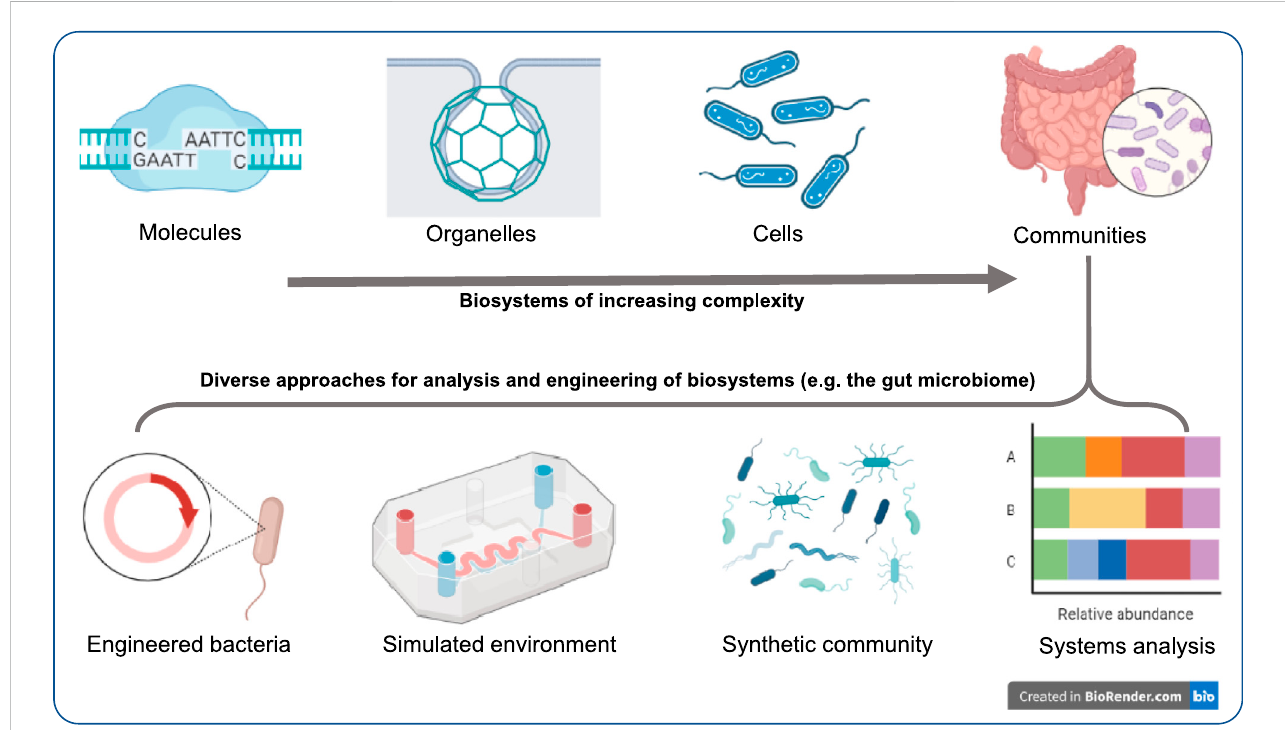
FIGURE 1 Understanding and engineering biological systems across scales: This article Research Topic represents new results and reviews on approaches that rangefromindividualmoleculesandorganellestocellsandtheircommunities.TheResearchTopicalsodemonstratesthatatanyofthesescales,multitudeof approaches can be used for analysisand bottom-up engineering, which lays thegroundwork for detailed understanding and designing practical applications. For example, to understand the microbiome and to devise technologies to address its dysbiosis, in addition to systems analysis of the native gut, engineered systems and methods for engineering synthetic communities to simulate the interaction, or simulating the gut environment (organ-on-a-chip type micro fl uidic devices), or utilizing synthetic diagnostic bacteria can provide unprecedented insight. Further attesting to their promise, the Food and Drug Administration (FDA, 2022) recently identi fi ed such microphysiological systems as one of the priority areas [Advancing Alternative Methods at FDA] to foster innovative